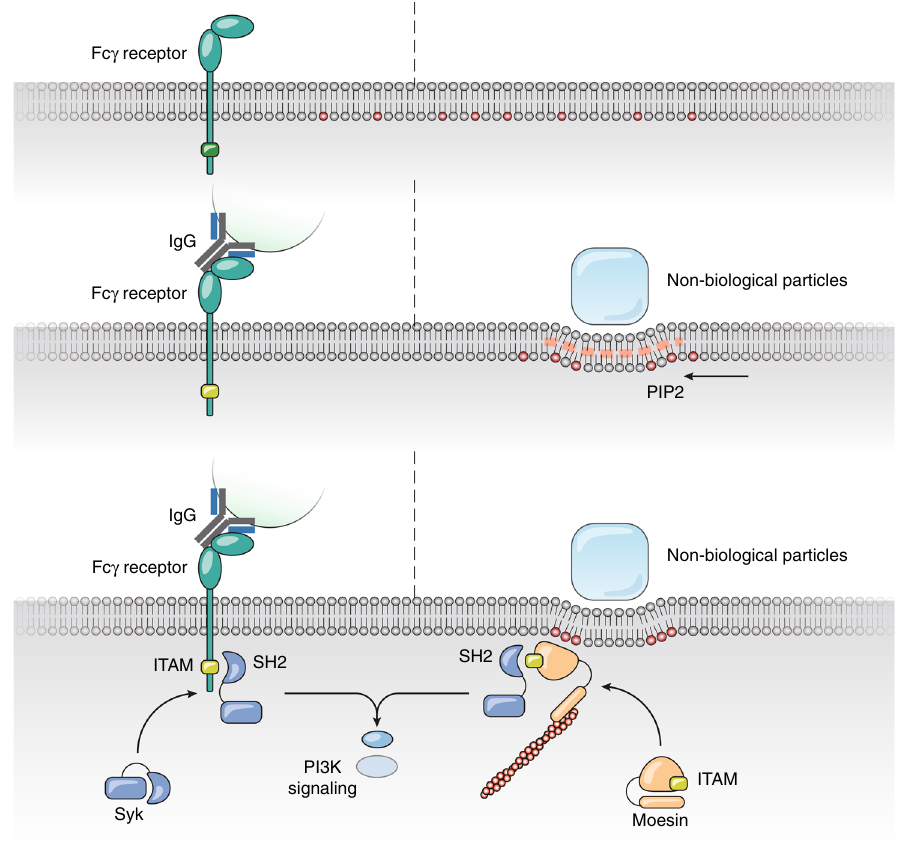
Fig. 8 A summary model. A scheme of potential model how FcR and PIP2 redistribution-based mechanisms can share the entire signaling cascade downstream of ITAM for phagocytosis. When solid particles are engaged with plasma membrane, the binding induces membrane curvature change and sorting of PIP2 at the site of contact. This leads to the membrane recruitment of Moesin and its activation. Binding of Syk to Moesin consequently leads